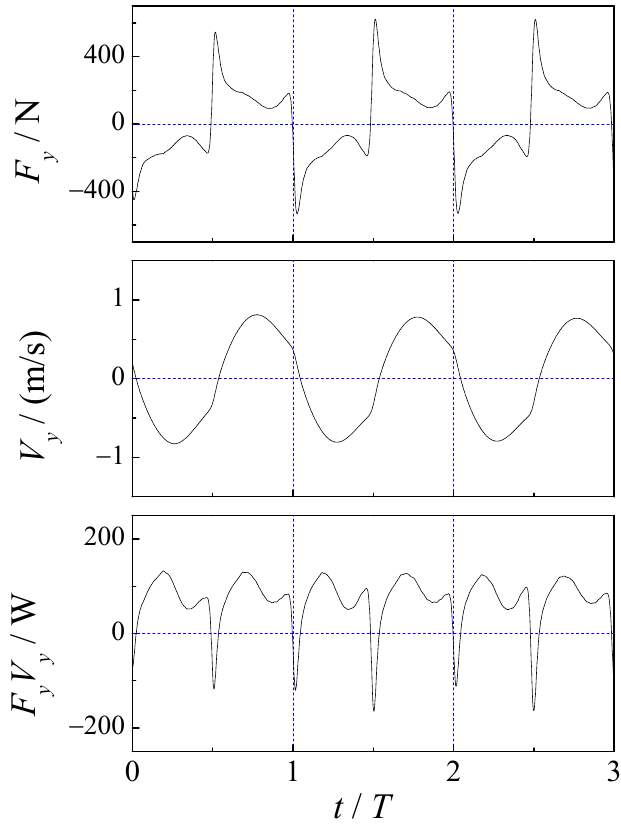
Figure 12. Time traces of the F y , v y , and F y v y with damping coefficient ζ = 0.177 in the baseline case.